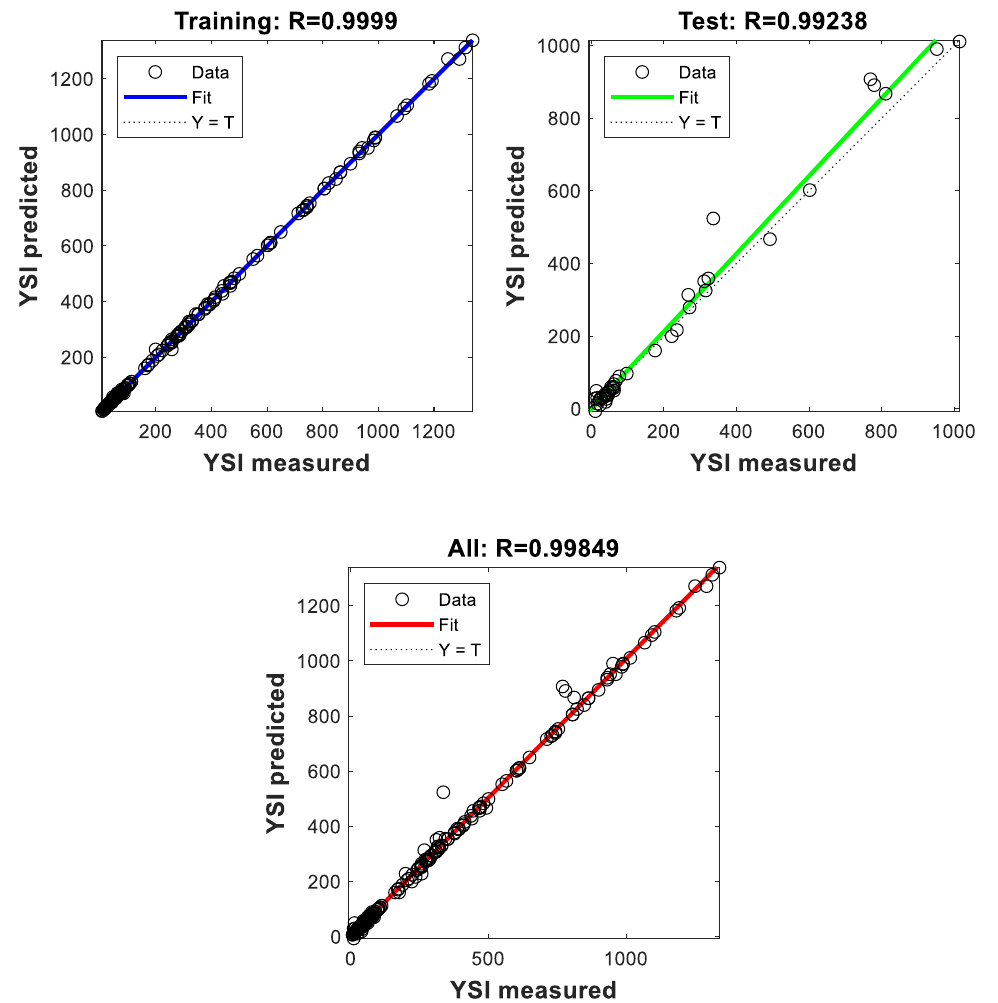
Figure 13. Comparison between the measured and predicted values of YSI in the training set, test set, and entire dataset.